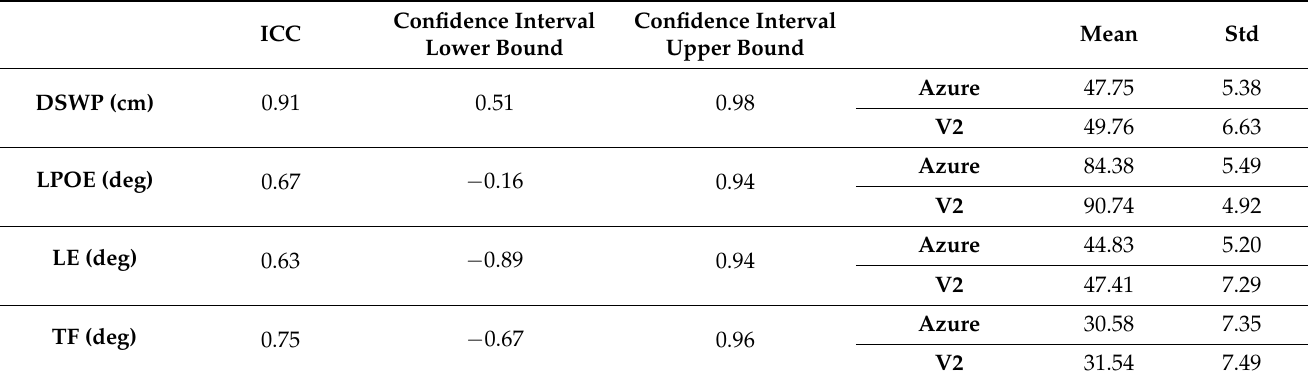
Table 6. Inter-rater reliability ICC 2,1 between Azure and V2.